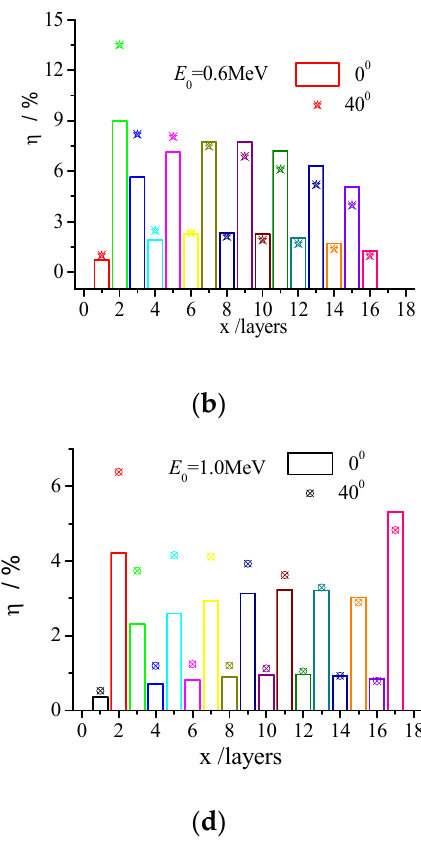
Figure 11. Energy deposition rates of different energy electrons in multilayer structures. ( a ) 0.4 MeV.